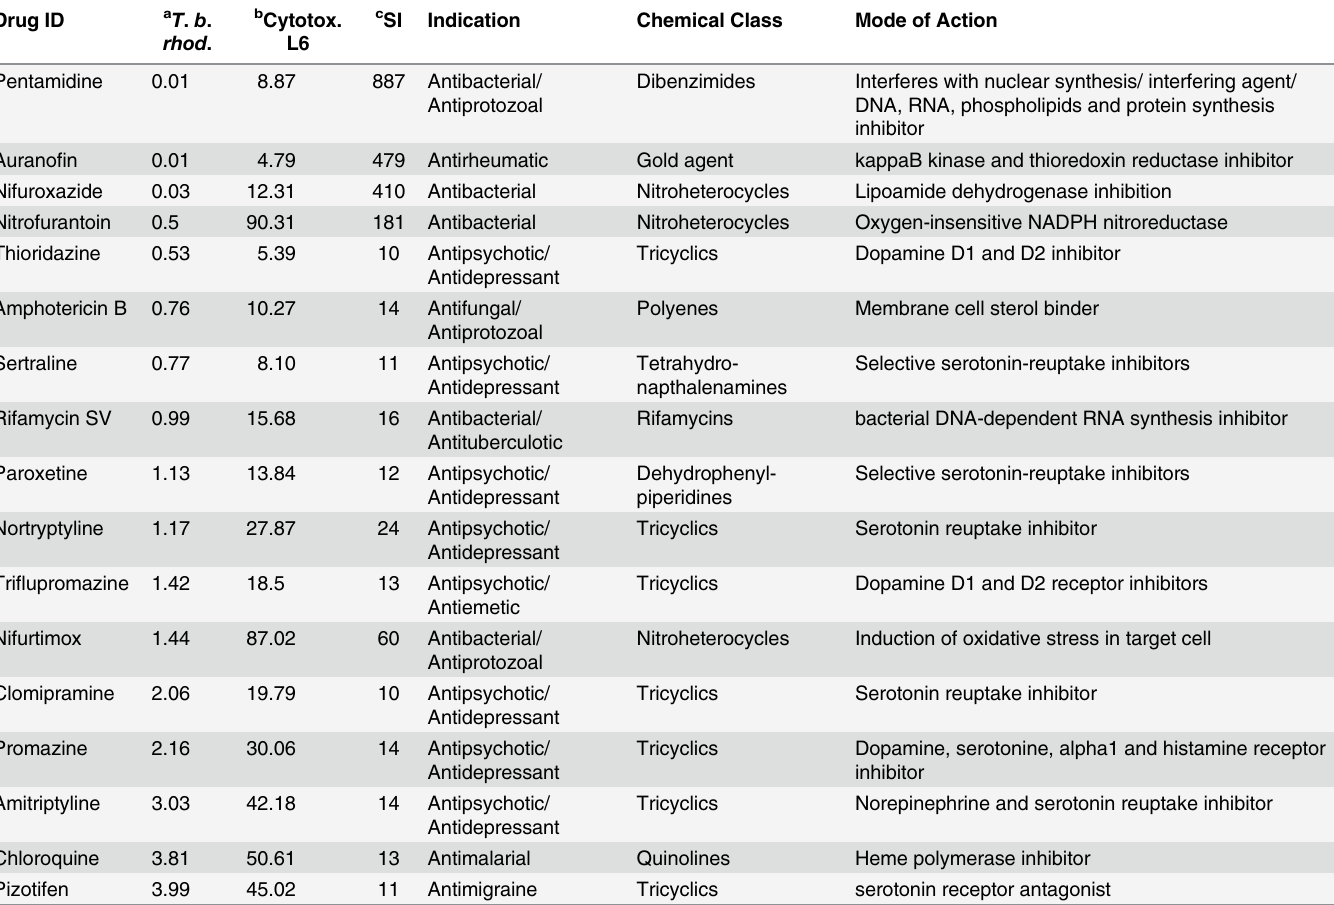
Table 1. In vitro activity against T.b. rhodesiense in IC50 ( μ M) of compounds fulfilling hit criteria. Drug ID a T . b . rhod